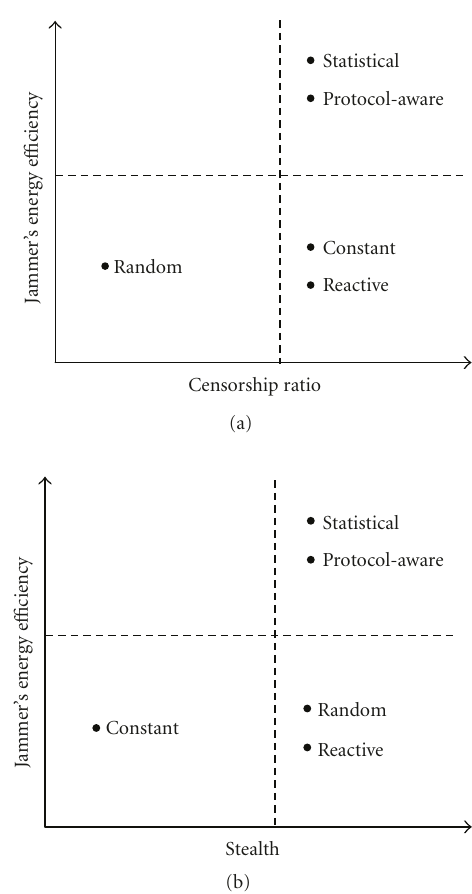
Figure 1: (a) Jammer’s Energy e ffi ciency versus Censorship ratio and (b) Energy e ffi ciency versus